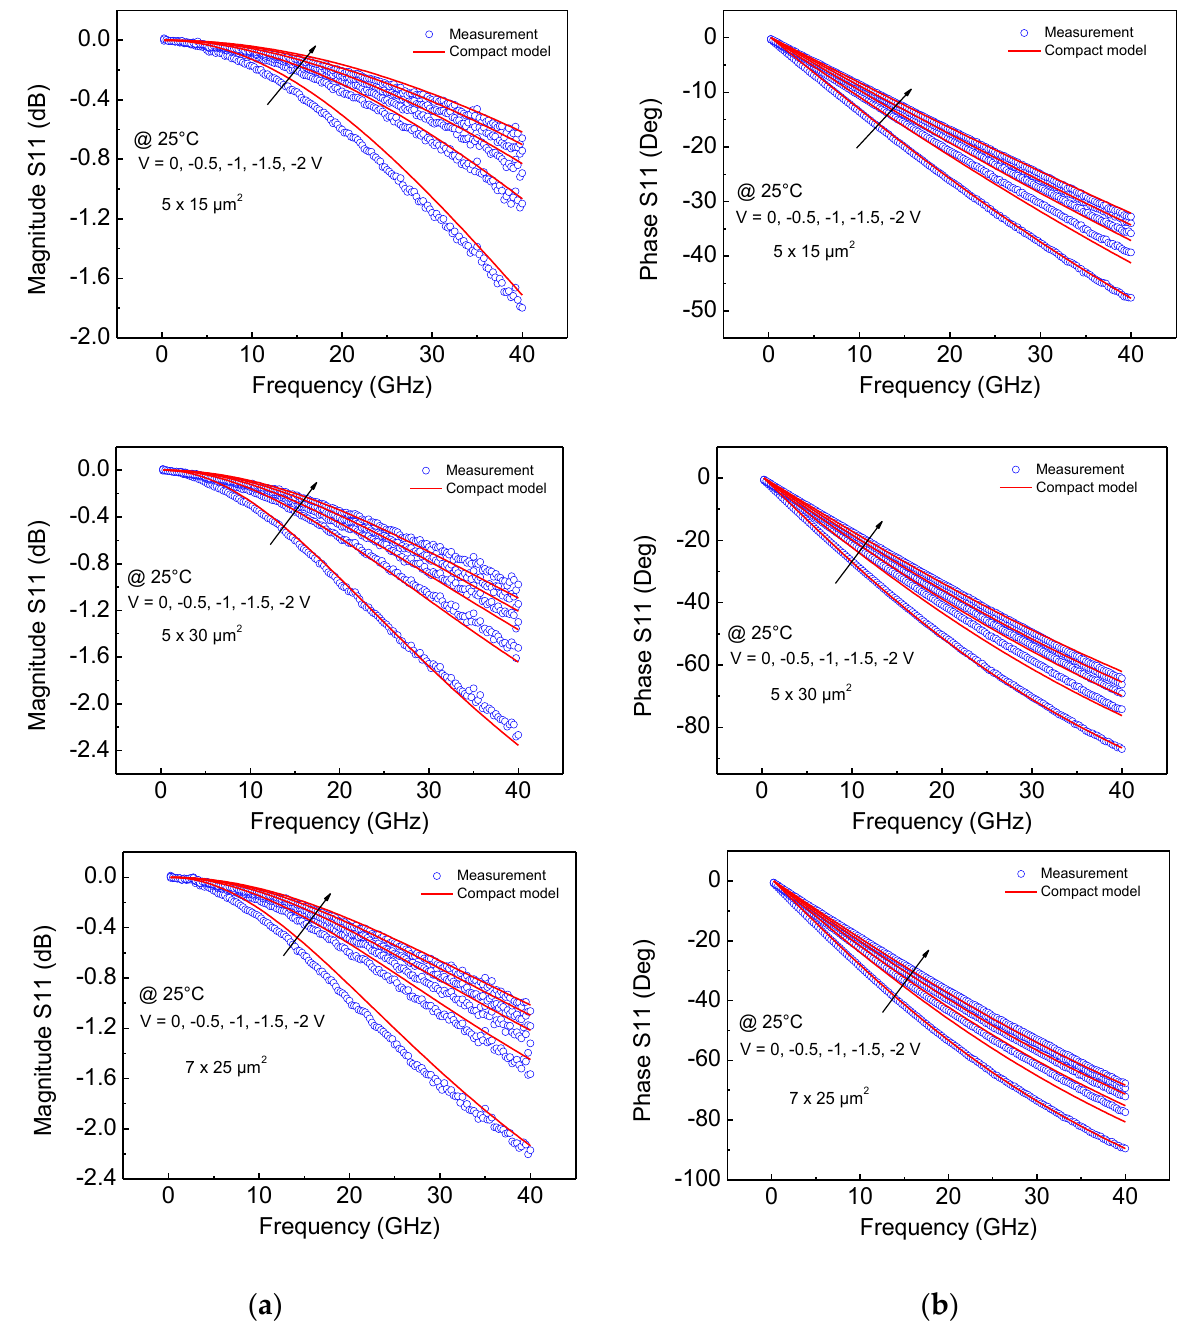
Figure 18. Measured (symbol) and simulated (line) S 11 parameter for three geometries 5 × 15, 5 × 30 and 7 × 25 μm 2 : ( a ) magnitude, ( b ) phase.